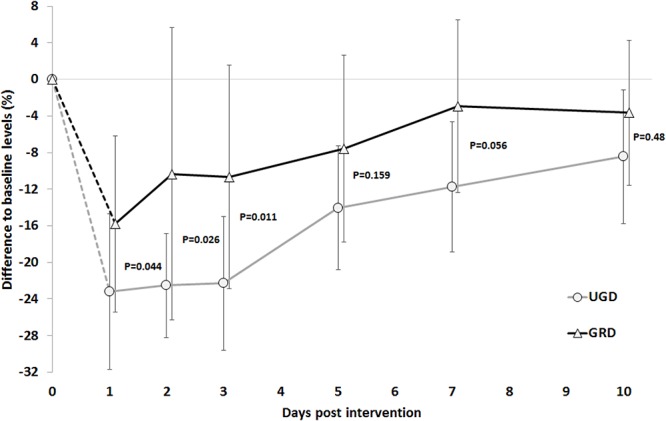
Time course of the % reductions with respect to baseline levels in the isometric maximal strength for the dominant leg across the 10 days post intervention period. UGD, sham-grounded sleeping group; GRD, grounded sleeping group (mean ± SD).